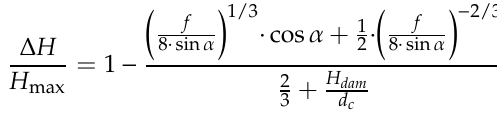
Figure 21. TKE estimated with the air entrainment model for both cases wall (W) and step (S) abutments at x = 20 m; 50 m; 100 m and 150 m when Z up = 52 m.